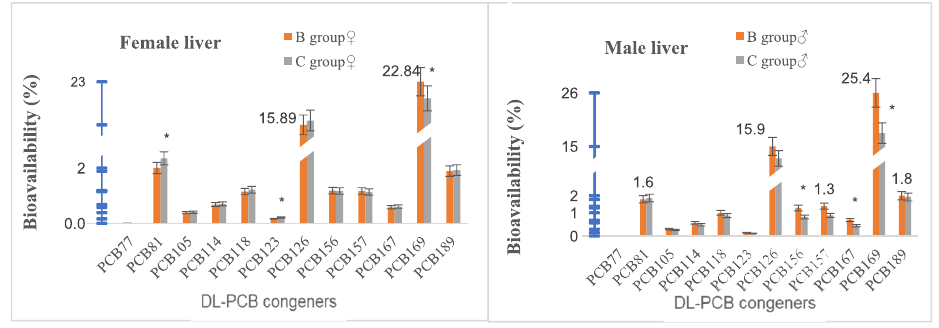
Figure 4. Effects of curcumin on bioavailability of DL-PCB congeners (* p < 0.05) (drawn with Microsoft